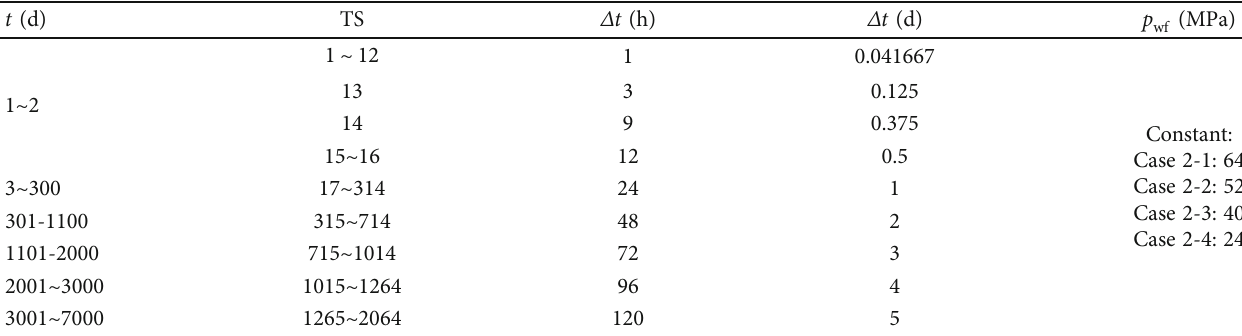
Table 5: Production schedules for the numerical cases with high pressure at constant